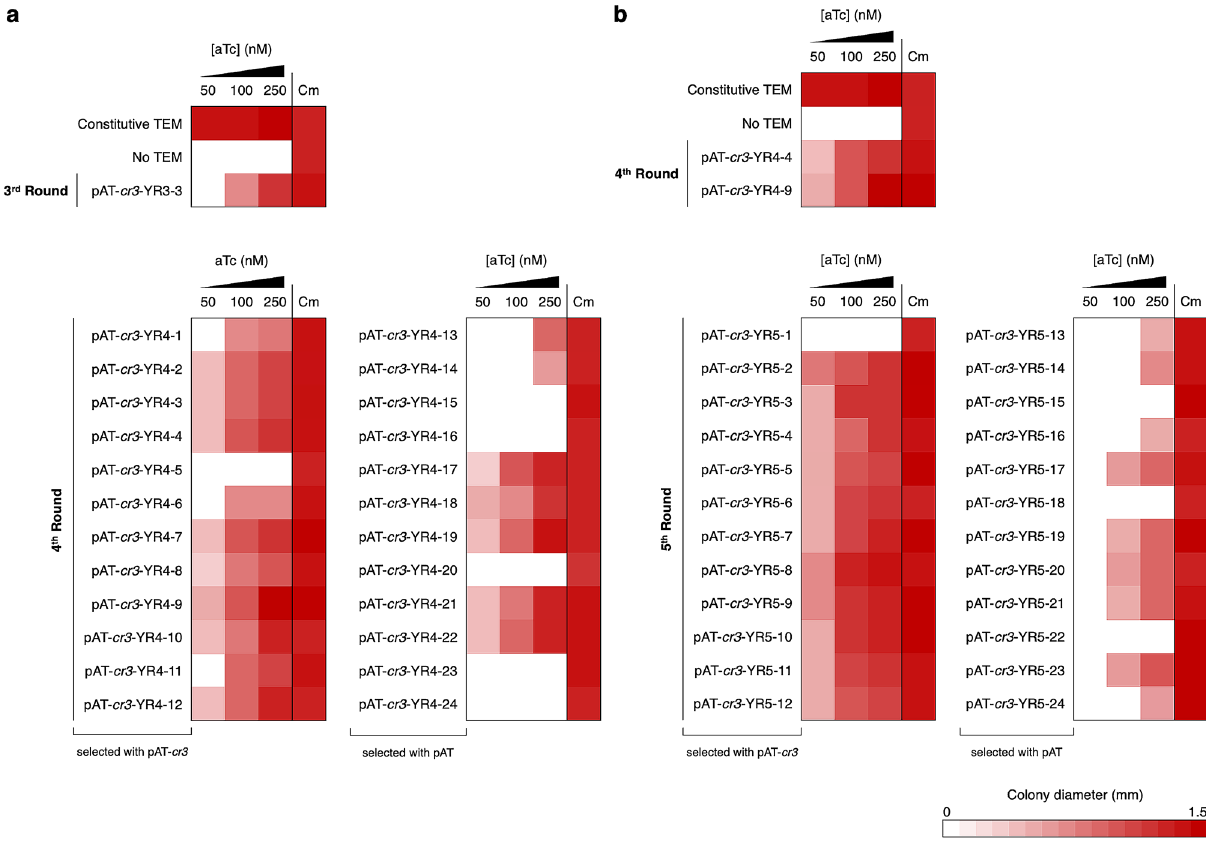
Figure 5. Heat map representing the average colony diameter of E. coli XL1-Blue expressing E166Y TEM variants selected from the fourth ( a ) and fifth round ( b ) of directed evolution. All selected gene variants were subcloned into pAT- cr3. Each TEM variant-expressing E. coli strain was grown on LB Amp50 containing varying concentrations of aTc and on LB Cm30 at 37 °C for 24 h. E. coli XL1-Blue containing the pAT- cr3 plasmid was used as the negative control. Colony diameters were determined by ImageJ 25 . The raw data are shown in Tables S7 and